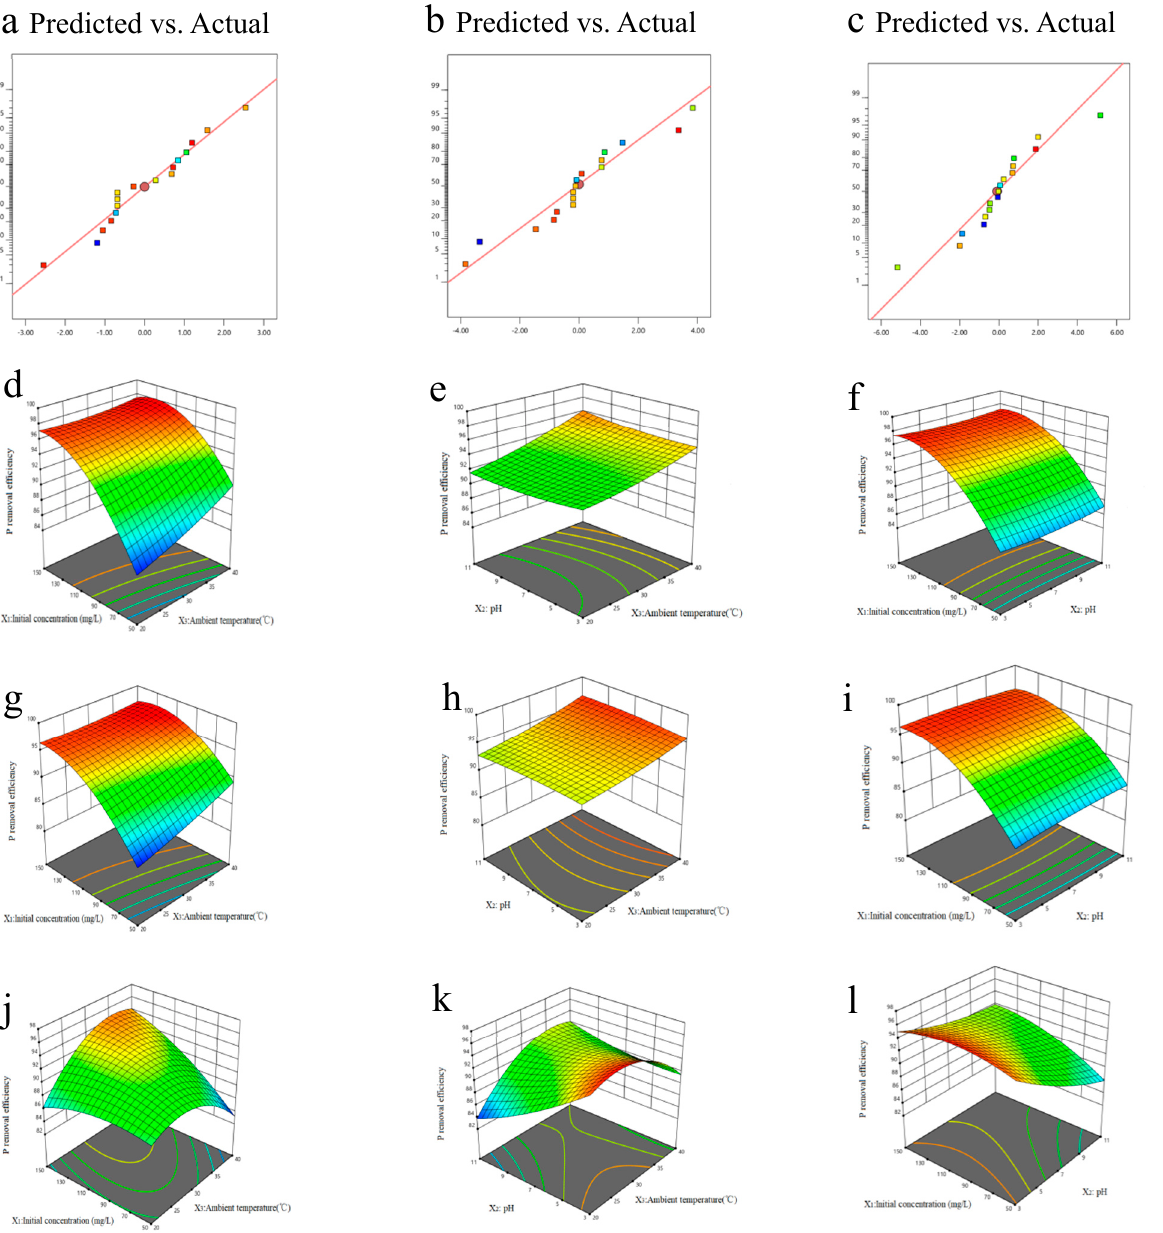
Figure 5. Correlation of the predicted and experimental PO 43- removal efficiency of MS ( a ), MP ( b ), and MR ( c ). The 3D surface simulation of C Initial concentration vs. T Ambient temperature ( d , g , j ), pH vs. T Ambient temperature ( e , h , k ), and C Initial concentration vs. pH ( f , i , l ) for the PO 43- removal efficiency of MS, MP, and MR, respectively.